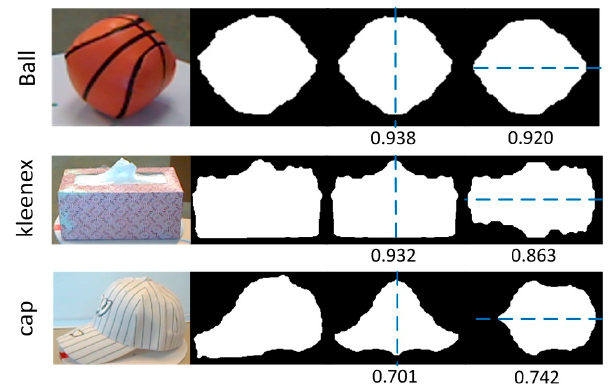
Figure 3. The symmetry score is computed as the ratio of the overlap area of original and reflected image to the area of the original image. Three categories are illustrated. Images in columns from left to right are: color images; mask images; overlap images along vertical axis; and overlap images along horizontal axis. The symmetry scores are labeled below.